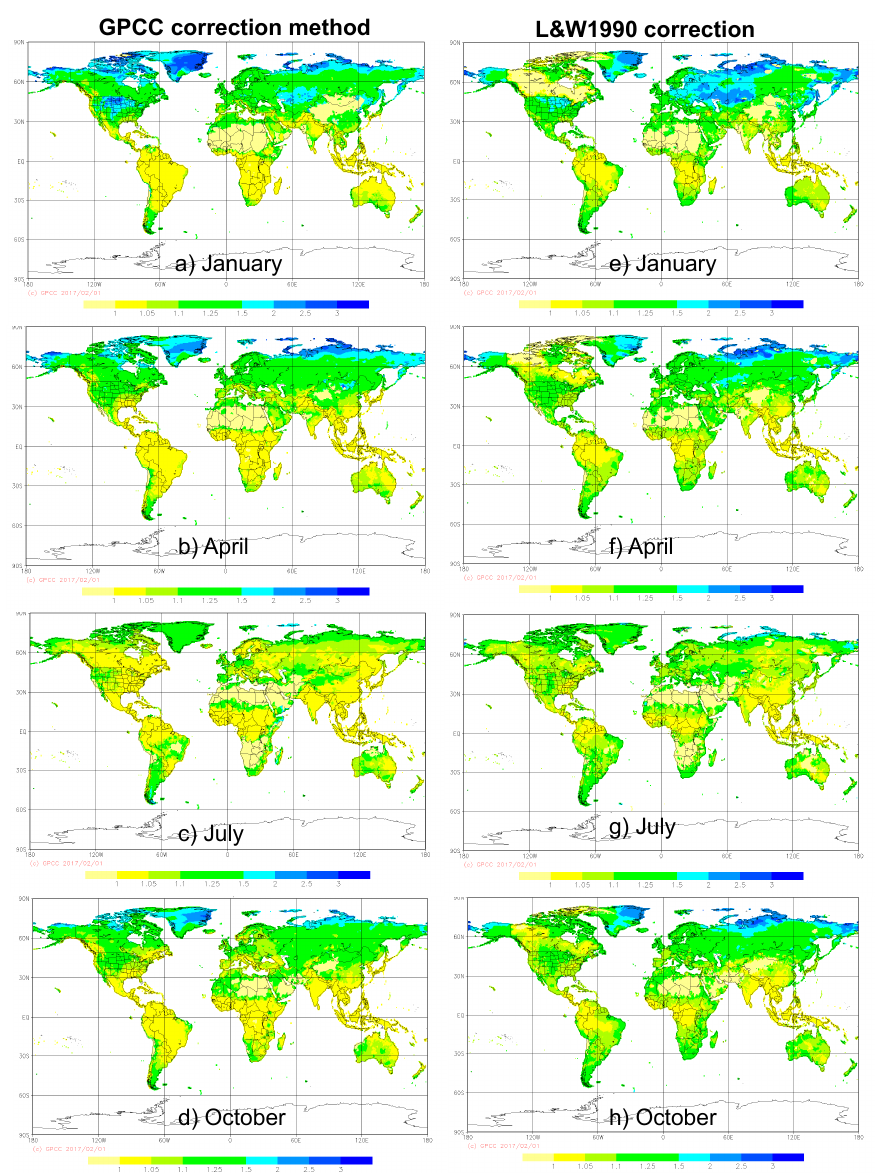
Figure 8. Mean correction factors from ( left ) GPCC correction method averaged for 1982–2015 for January, April, July and October and ( right ) Legates and Willmott (L&W1990, [8]) for the same